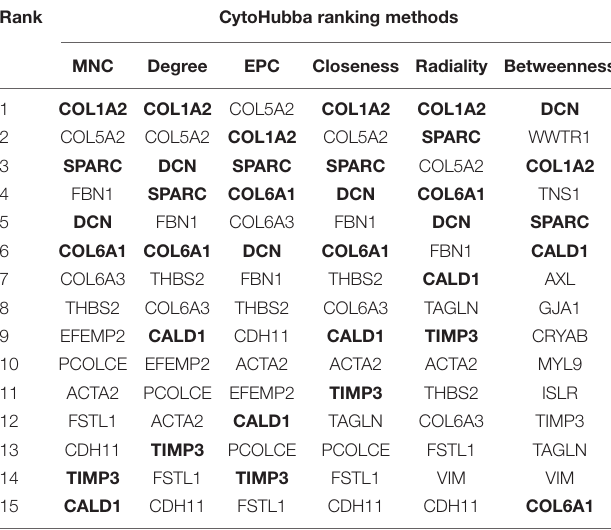
Symbols in bold type were the genes overlapped by six ranking methods in cytoHubba. MNC, maximum neighborhood component; degree, node connect degree; EPC: edge percolated